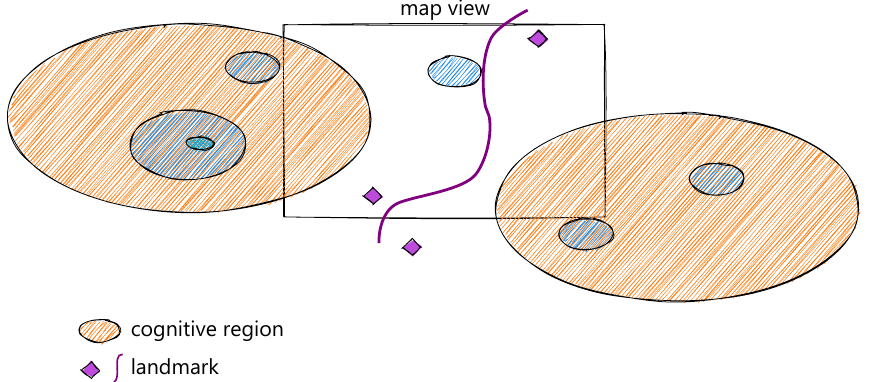
Figure 9. Illustration of the reconciliation process (i.e., locating the map view within one’s men- tal